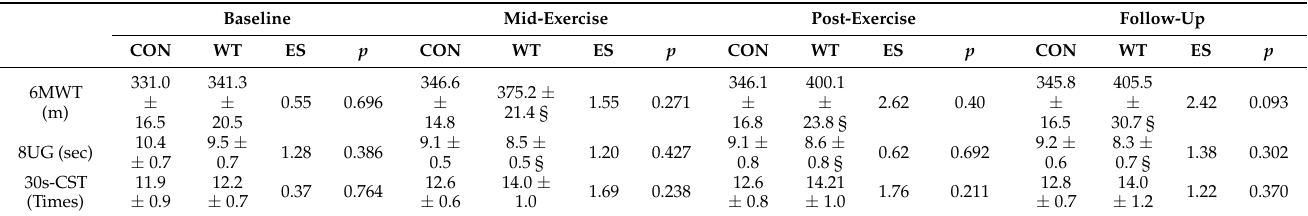
Table 4. Comparison of physical function fitness between the two groups of TKA